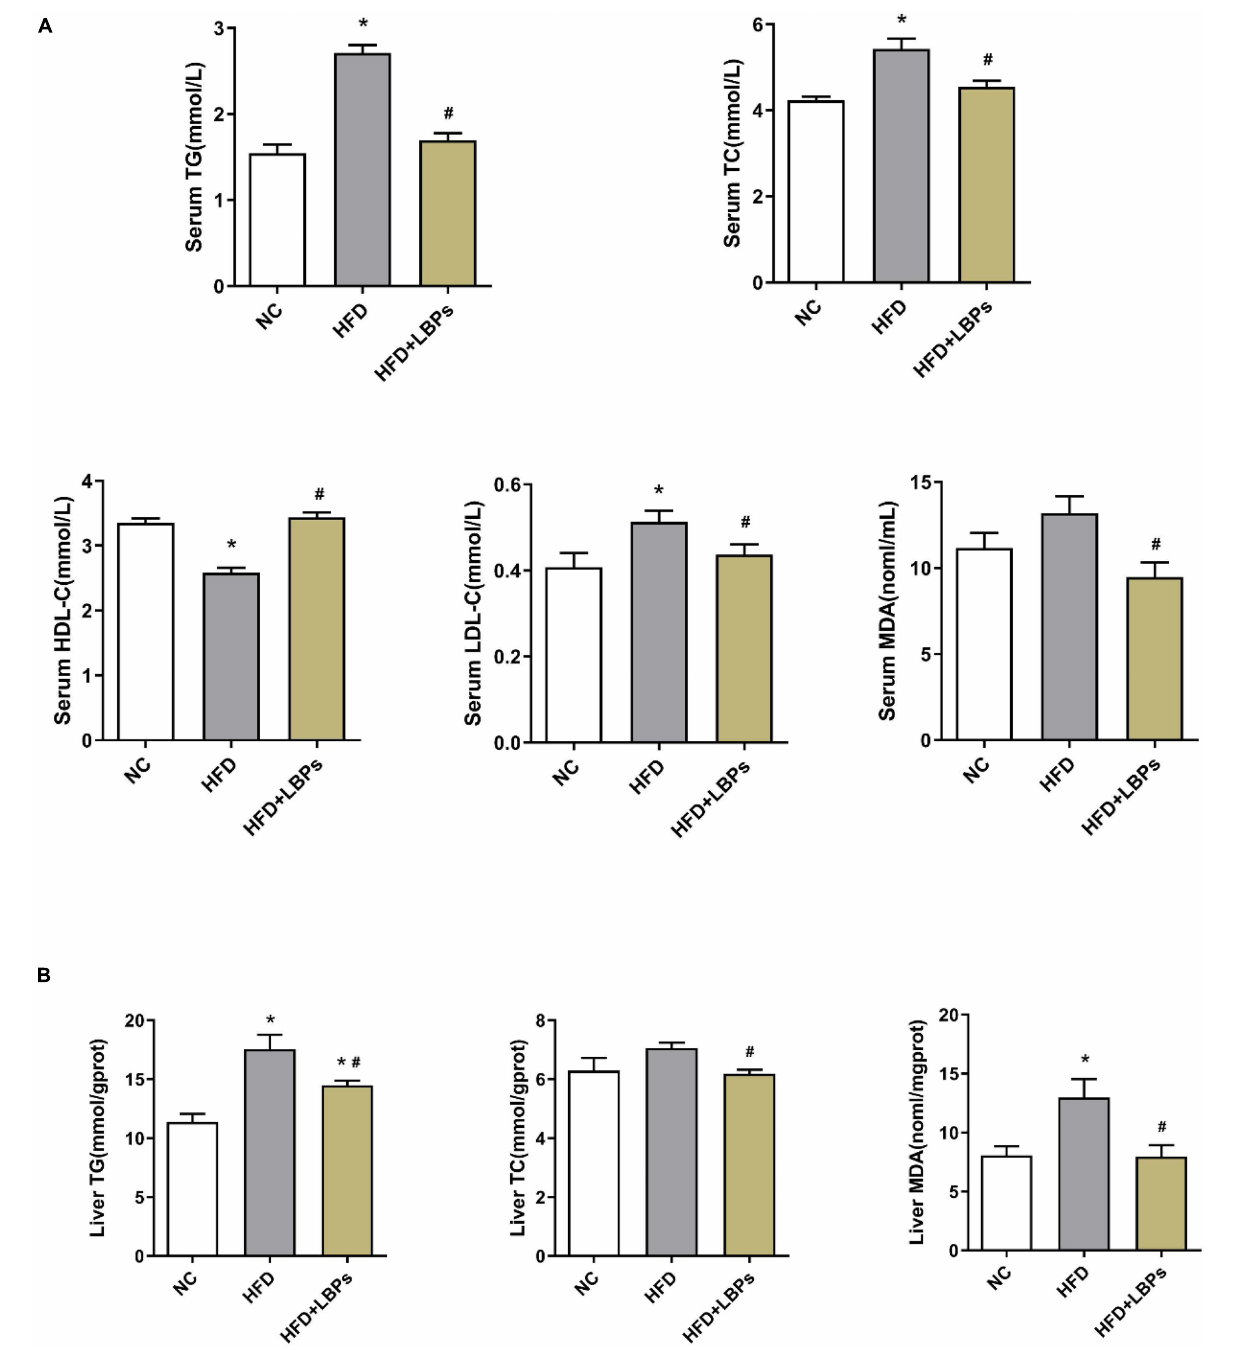
FIGURE 2 | Effects of Lycium barbarum polysaccharides (LBPs) on (A) serum and (B) liver lipids profile in HFD-fed mice. * P < 0.05 vs. NC group and # P < 0.05 vs. HFD group.